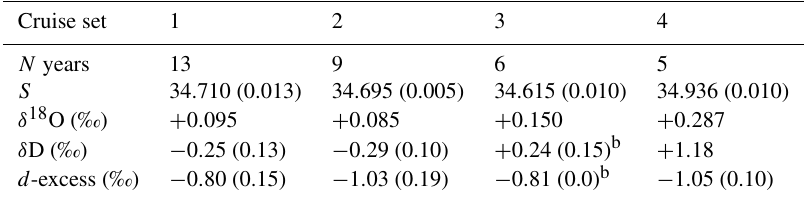
Table 2. Comparison of LOCEAN annually averaged data in a few selected deep-water masses which exhibit little variability in their salinity and have likely not been recently ventilated. S , δ 18 O, δ D, and d -excess values are first averaged for each year. The values reported are the mean and standard deviations of these yearly averages. The number of years ( N years) refers to the δ 18 O data. 1: OISO cruises (1998 to